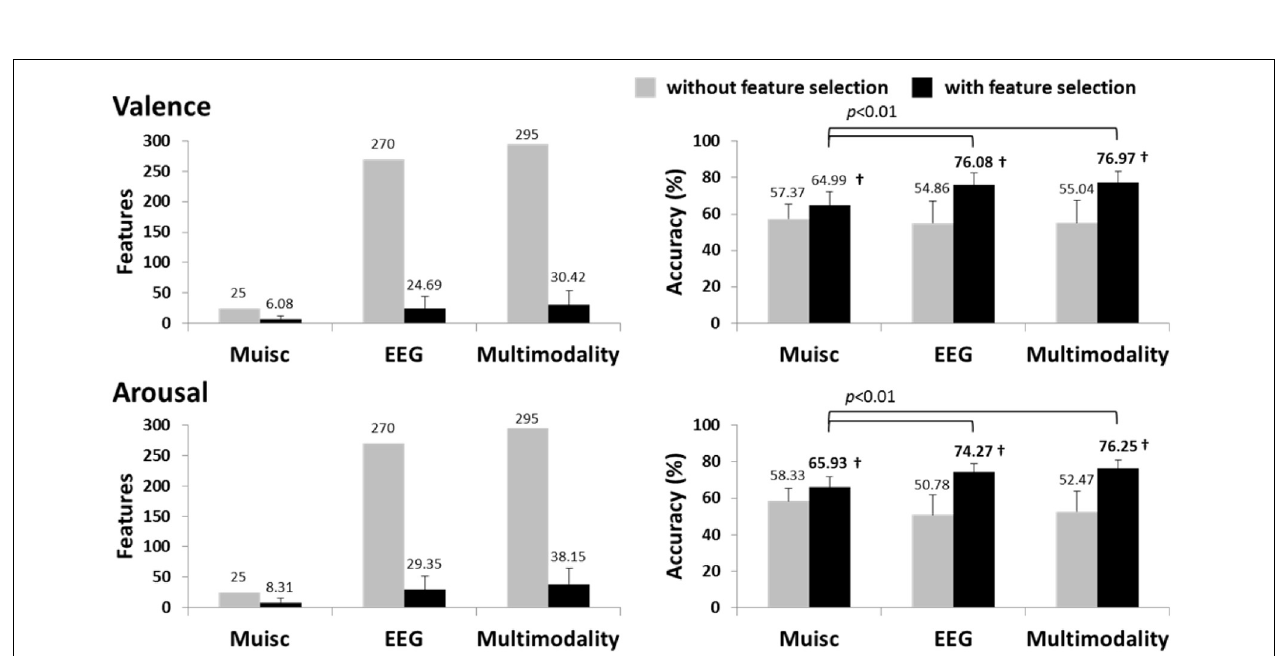
accuracies significantly better ( p < 0 . 01) than the majority voting accuracy (valence: ∼ 63%, arousal: ∼ 61%). † Indicates that the accuracy with feature selection significantly outperformed that without feature selection ( p < 0 . 01).